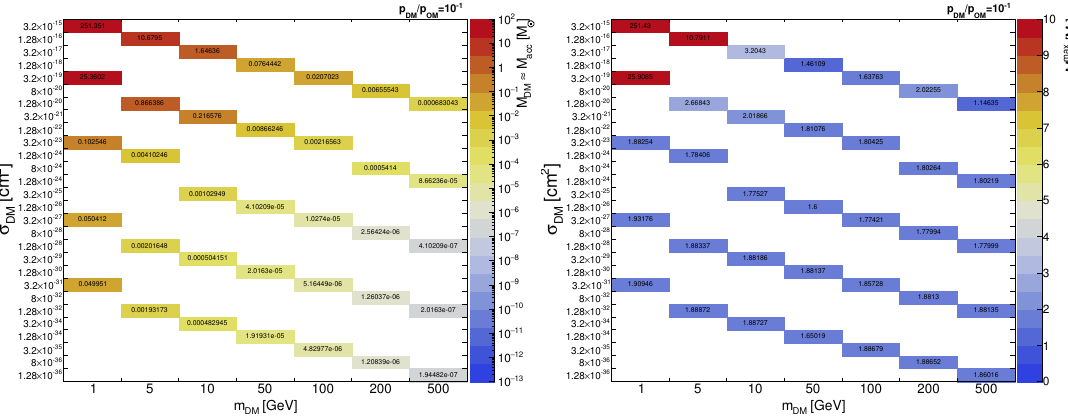
Figure 5. Self-interaction dark matter cross section, in the case p DM / p OM = 0.1. The red bins indicate forbidden regions of the parameter space, where the accumulated DM mass is much greater then ordinary mass of the NS. Therefore, the maximal total mass of NS goes over the conventional mass limit of 2 solar masses. The slopes indicating the different DM interaction parameter, y = 1000,100,10,1,0.1 from top to